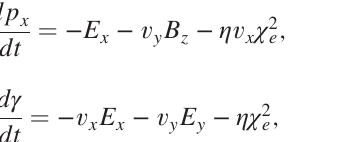
FIG. 1. (a) The schematic of a collision between the electron bunch and laser pulse. (b) and (c) present the dependence of p the electron ’ s initial transverse coordinate r 0 for the classical LL and QED case, respectively. (d) and (e) are the same as (b) and (c) but for p ⊥ . The black lines in (b) and (d) correspond to the theory of Eqs. (5) and